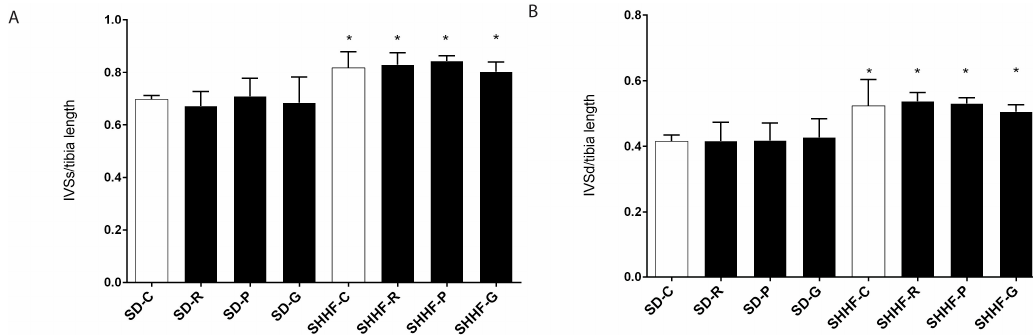
Figure 5. Stilbenoid treatment does not attenuate cardiac hypertrophy in the SHHF rat. Normalized ( A ) IVSs and ( B ) IVSd were increased in untreated SHHF (SHHF-C) compared to untreated SD (SD-C) rat hearts. 8-week treatment with resveratrol (R; 2.5 mg/kg/day), pterostilbene (P; 2.5 mg/kg/day), or gnetol (G; 2.5 mg/kg/day) did not affect normalized ( A ) IVSs and ( B ) IVSd in hearts from SD nor SHHF rats. n = 6–8. * p < 0.05 vs. SD-C hearts.